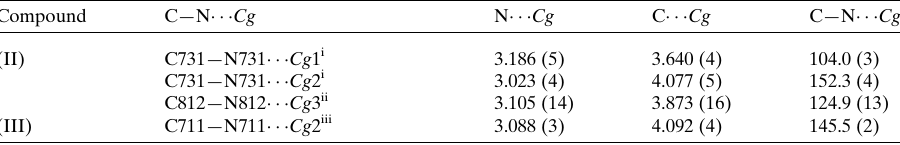
Table 2 Parameters (A˚ , (cid:5) ) for C—N (cid:2)(cid:2)(cid:2) (cid:2) contacts in compounds (II) and (III). Cg 1, Cg 2 and Cg 3 represent the centroids of the rings (N11, C12–C16), (N61, C62–C66) and (N31, C32–C36) respectively.